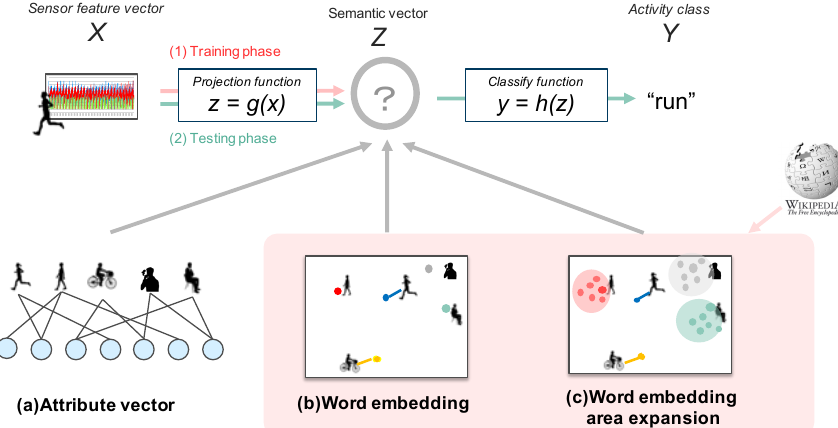
Figure 1. Overview of the zero-shot learning method. In the learning phase, we learn how to project feature vectors ( X ) onto semantic vectors ( Z ) from training data (red arrow). In the testing phase, we project test feature data onto the semantic space, and then identify the class ( Y ) to which the estimated semantic vector belongs (green arrow). In this paper, we compare 3 methods with different semantic